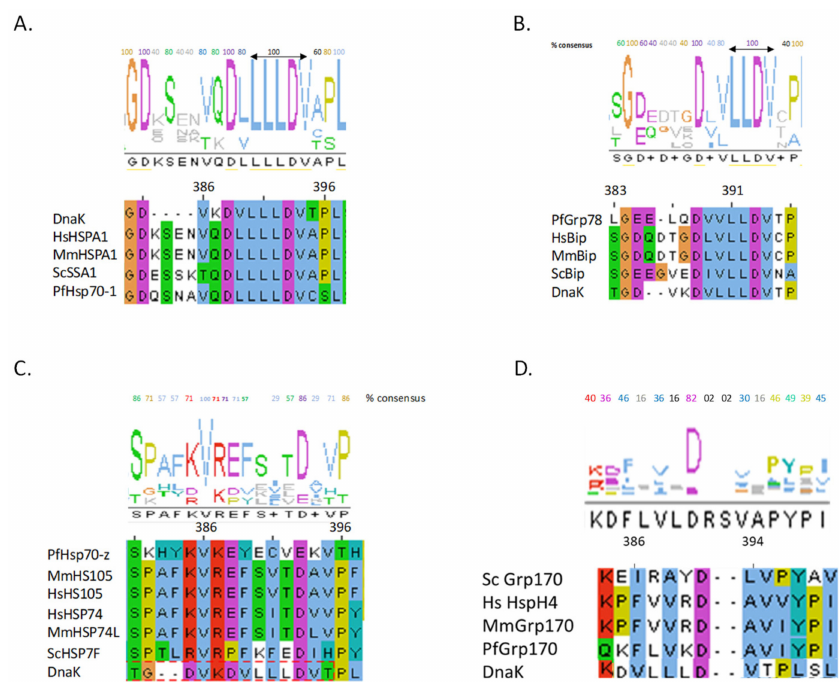
Figure 2. Linker segments of Hsp70s.The data represent linker segments obtained using multiple sequence alignments from at least 500 DnaK homologues and these were sub-grouped based on the conservation level among various Hsp70 clades: ( A ) canonical Hsp70s; ( B ) E.R. Hsp70 homologues; ( C ) Hsp110 homologues and (D) E.R. Grp170